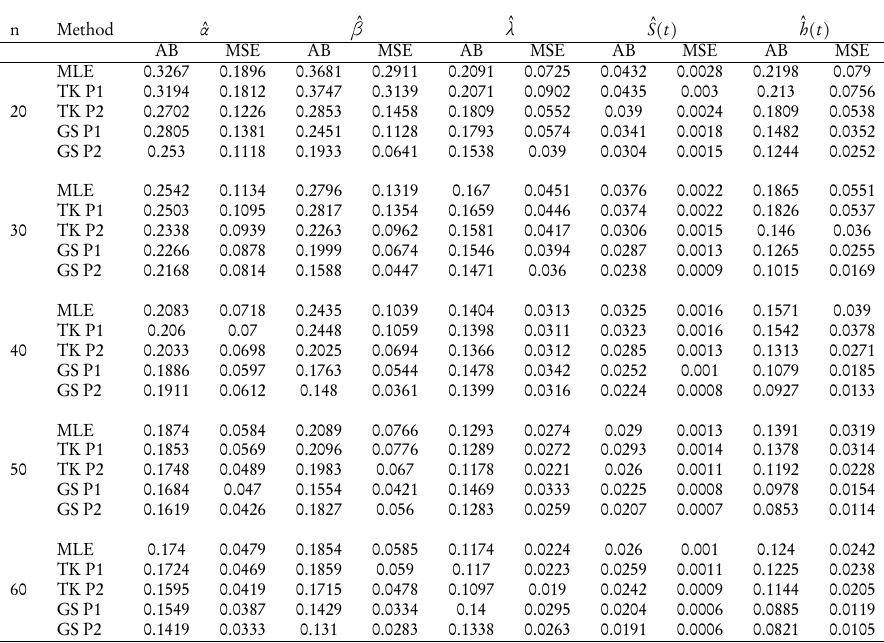
The ML and Bayes estimates of parameters and reliability characteristics when α = 2, β = 1.5, λ =